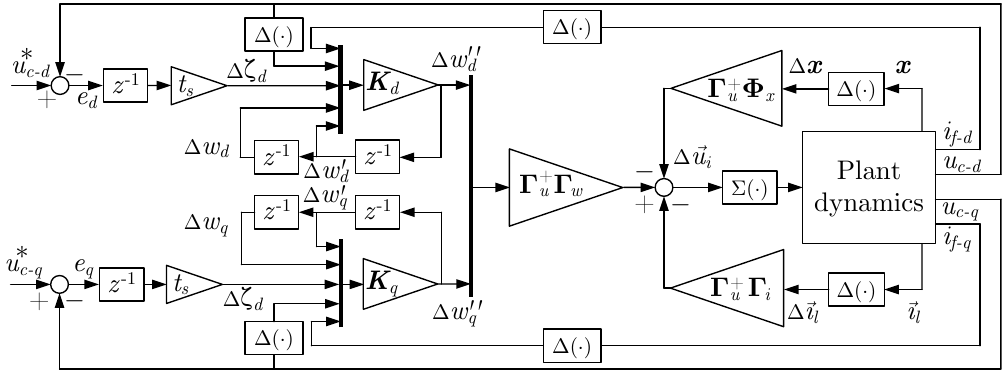
Figure 5. Incremental form of the state-feedback (SF) controller. ∆ ( · ) stands for the incremental operator and Σ ( · ) stands for the accumulation operator (the state-variable predictions are not shown for simplicity).